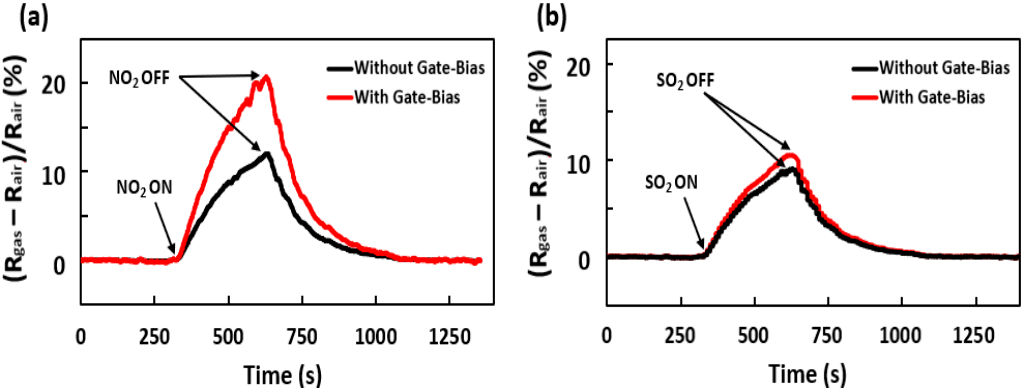
Figure 3. Sensor response to 10 ppm of ( a ) NO 2 and ( b ) SO 2 with and without applying gate bias voltage of 30 V under UV light in dry air at room temperature (20 ° C ).